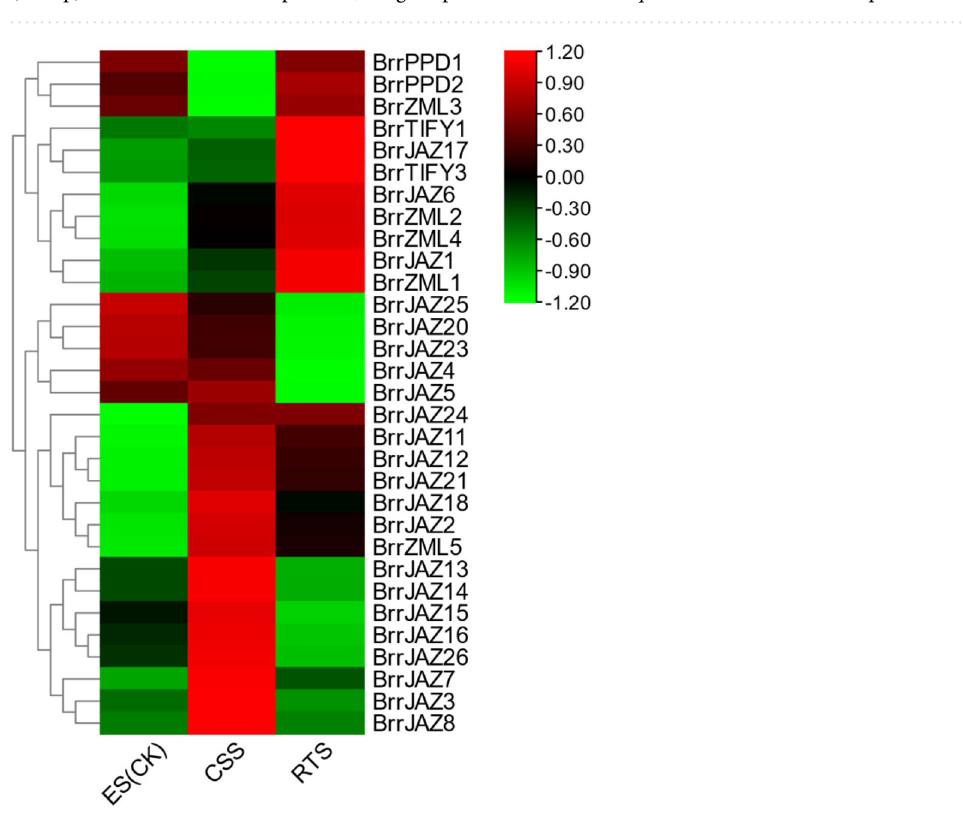
Figure 6. Collinear association of Arabidopsis thaliana , Brassica Oleracea and Brassica rapa subsp. rapa (turnip). Blue lines indicate duplicated JAZ gene pairs between Arabidopsis , B. oleracea , and turnip.